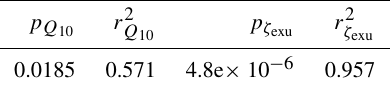
Table 5. The p and r 2 values of the regressions of the Q 10 (–) parameters against the mean soil temperature of the first 10 weeks of the year at the depth of 35cm, and the ζ exu parameters against the sum of the net primary production of the first 130 days of the year. p Q